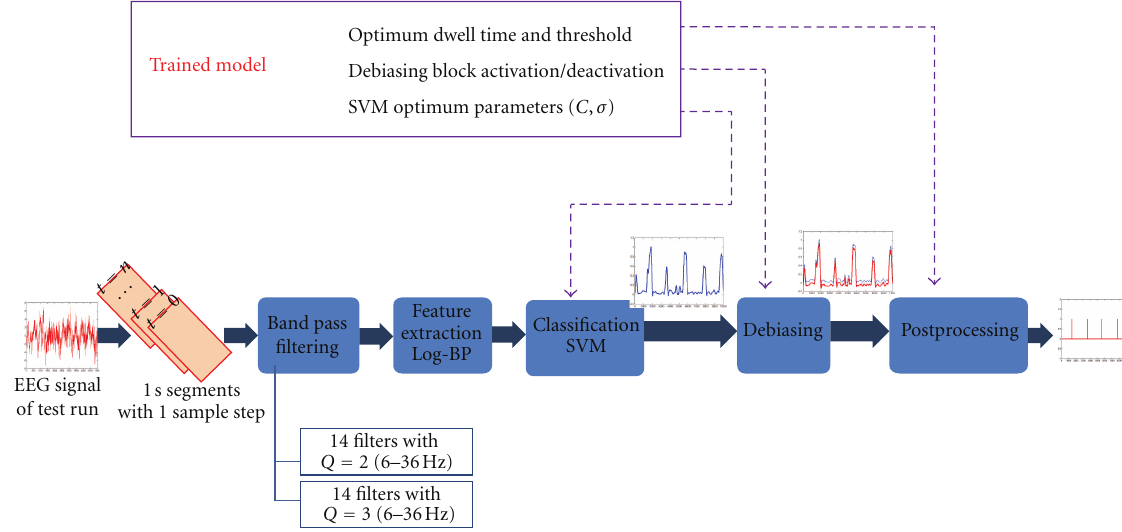
Figure 4: Online self-paced brain switch block